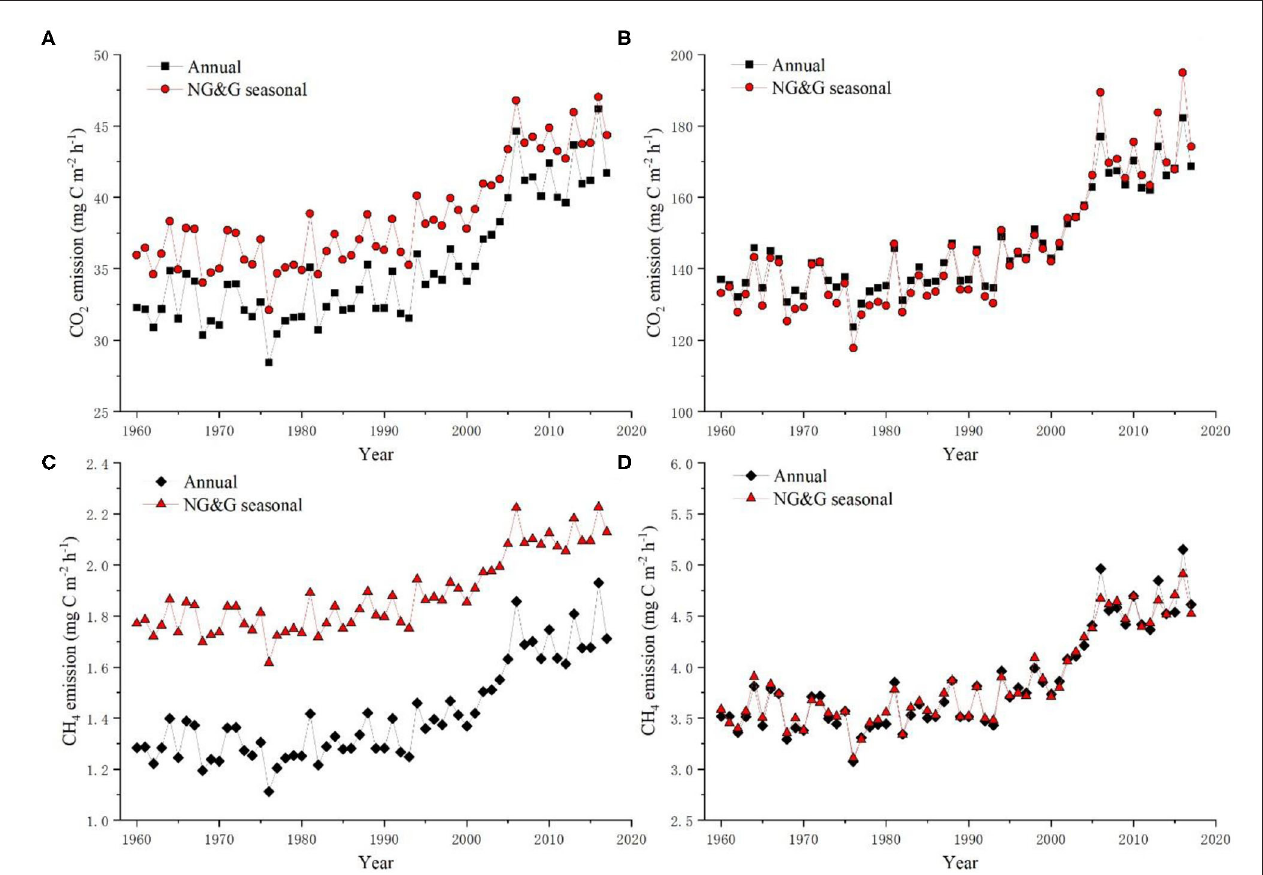
FIGURE 4 | Annual CO 2 and CH 4 emission rates of the study site from 1960 to 2017 were extrapolated based on regression models between soil temperature and CO 2 /CH 4 emissions measured using the static chamber method (A,C) and using the eddy covariance method (B,D) at different timescales (Annual or NG&G seasonal).